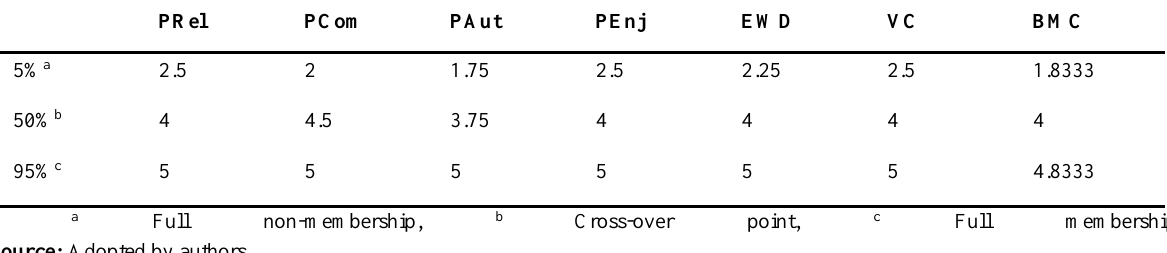
Table 6 : Compute thresholds using percentiles